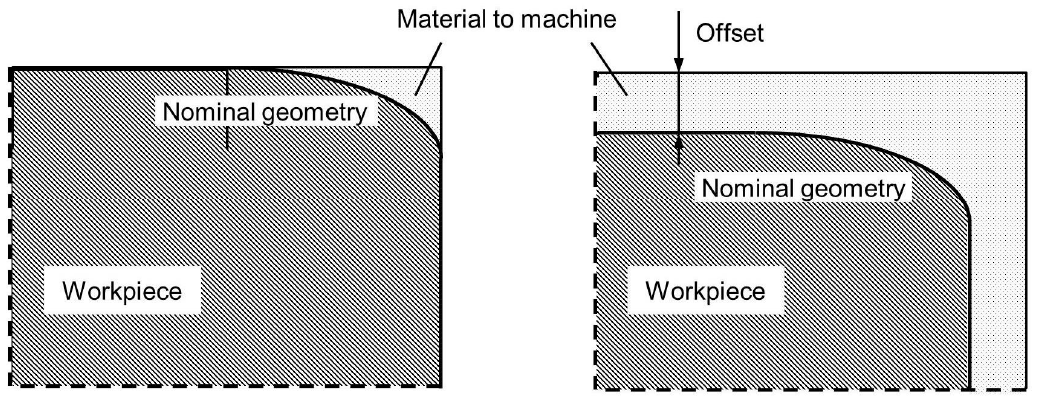
Figure 2. Offset of nominal geometry to increase material removal rates.